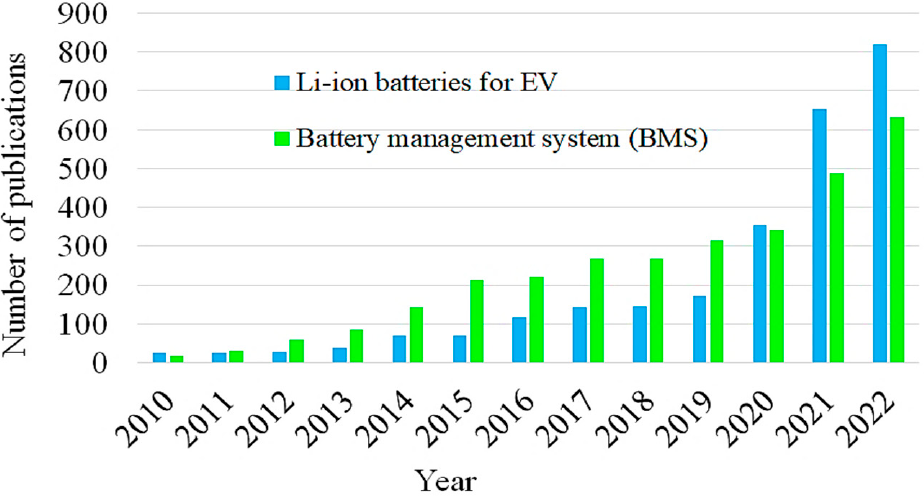
Figure 2. Number of reviewed published articles on BMSs (data sources: Scopus; keywords: Li-ion battery for EV and battery management system; access date: 25 November 2022).